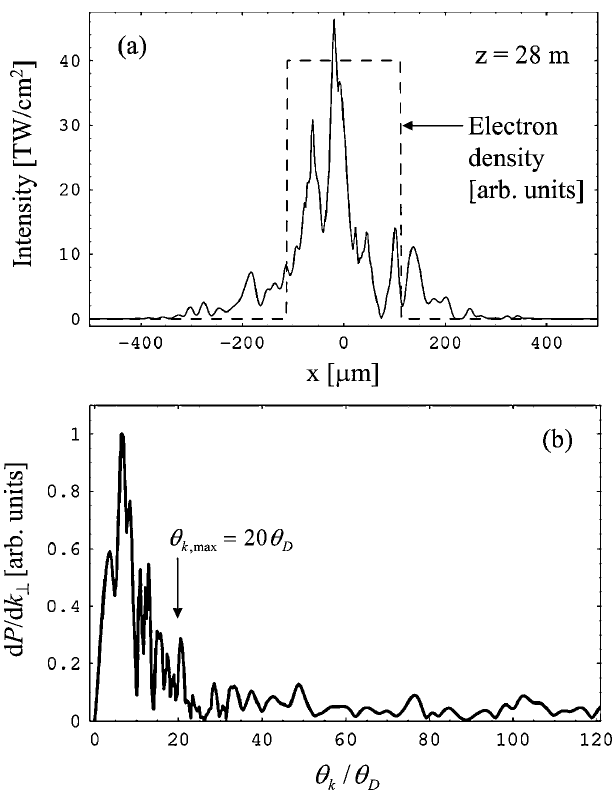
FIG. 8. (a) GENESIS simulation result showing transverse pro- file of intensity (solid curve) at z ¼ 28 m (saturation) for the LCLS FEL. The dashed curve denotes electron beam profile. (b) Distribution of power over normalized transverse wave number (propagation angle), for the intensity profile shown in (a). The propagation angle is normalized to the diffraction angle (cid:7) and (cid:7) denotes the maximum propagation gain angle used D k; max in calculating the theoretical coherent power in Fig.